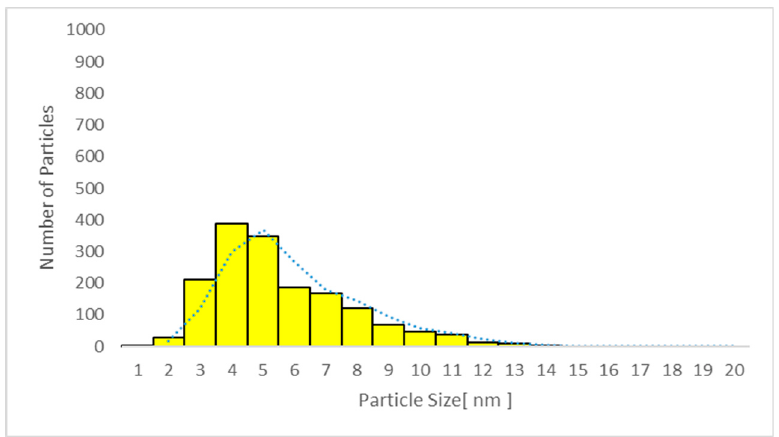
Figure 13. Particle size distribution determined by transmission electron microscopy (TEM) in urine sample 4 in study C (sunscreen + UV). The average particle size was 6.2 nm in all subjects. 3.7. FeNO